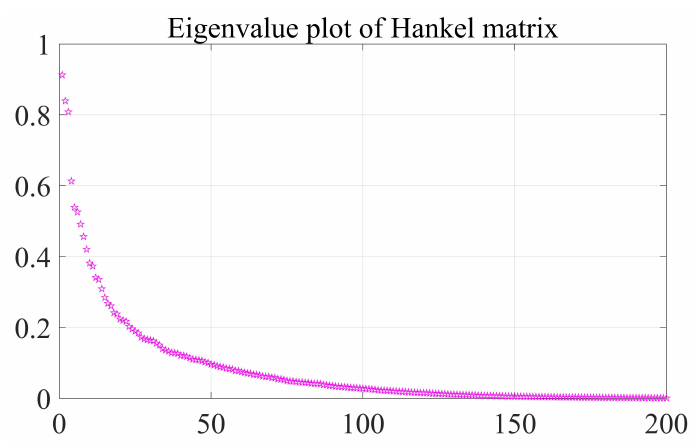
Figure 5. Eigenvalue figure of Hankel matrix.